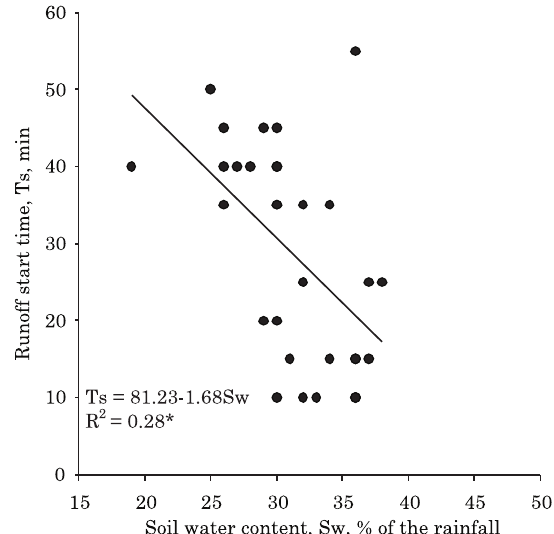
Figure 1. Relationship between runoff starting time (Ts) and soil water content before the rainfall, Sw, in the 10-20 cm layer, considering all treatments and rainfall tests (n=32).